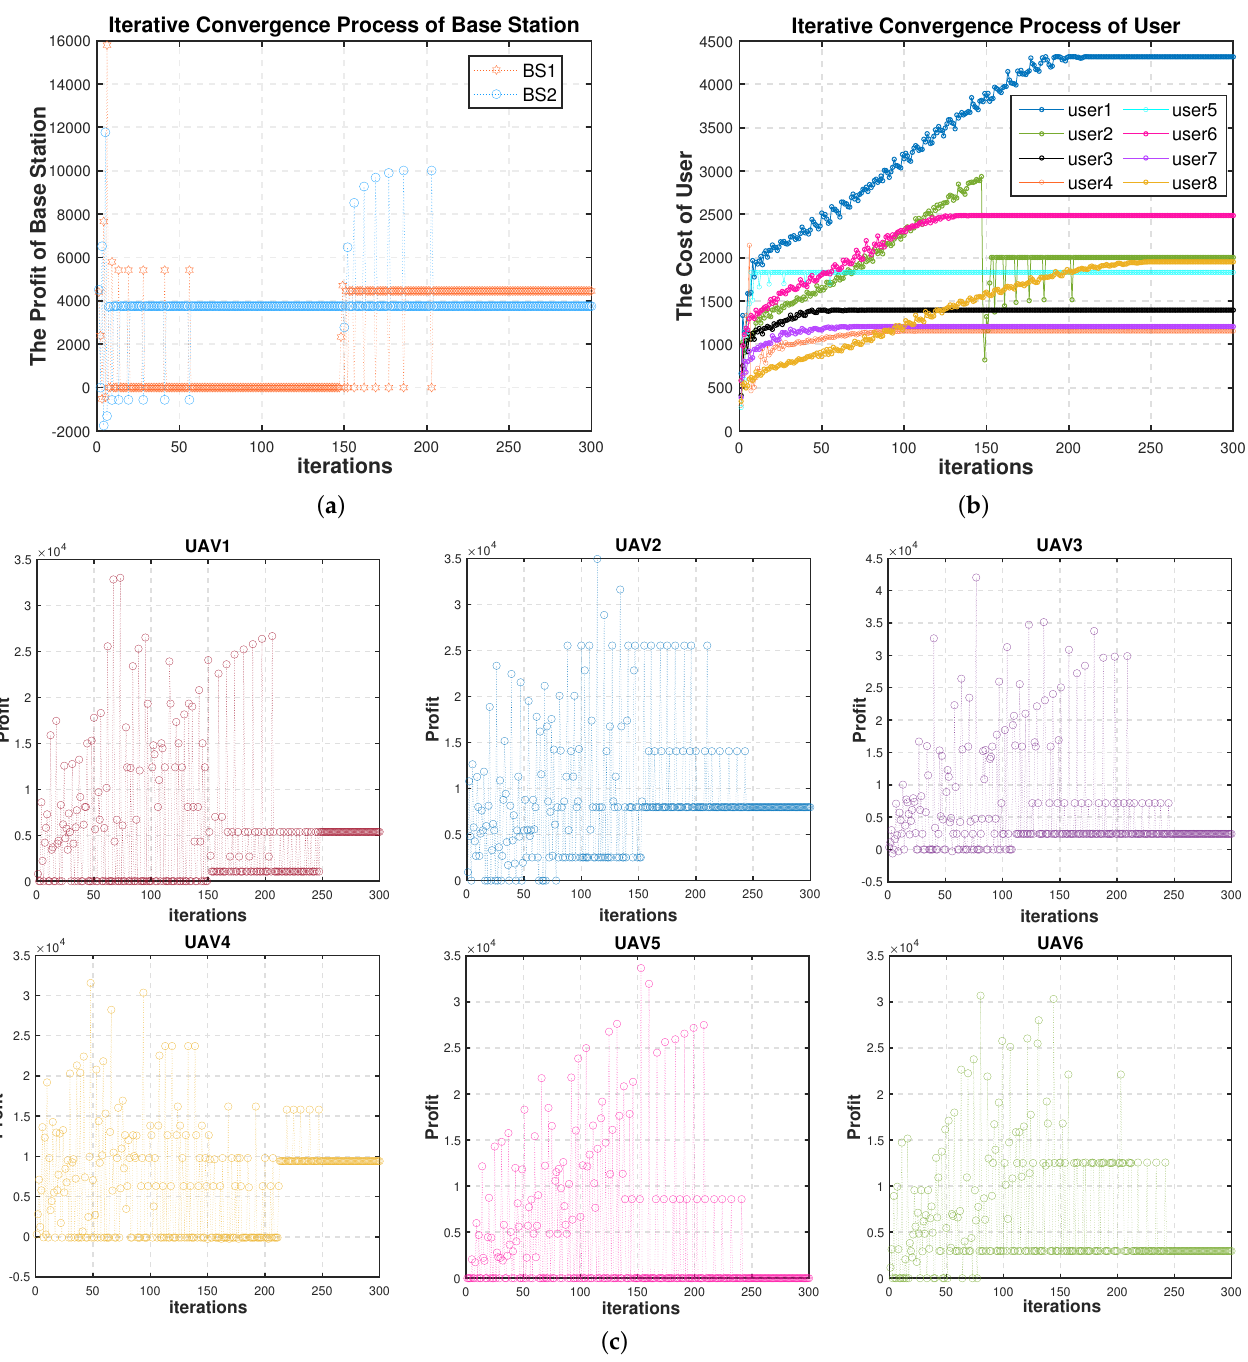
Figure 3. Iteration process in each layer. ( a ) iteration process of base stations. ( b ) iteration process of users. ( c ) iteration process of